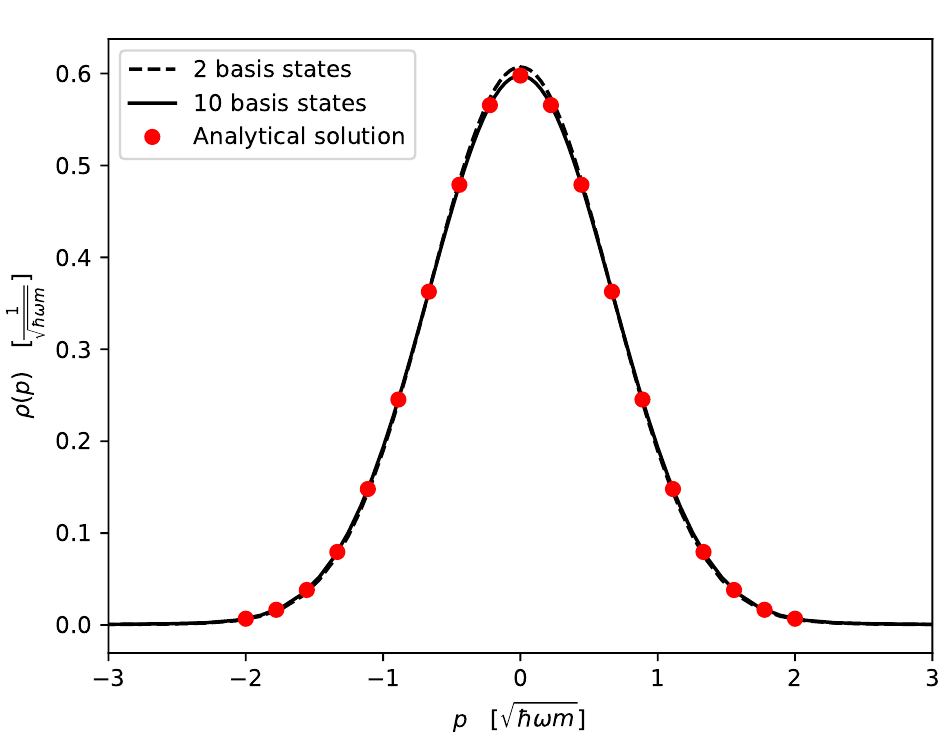
Figure 6: Momentum distribution of one of the particles in the ground state at (cid:113) m = 1 for the 1 + 1 system in the harmonic trap, compared with the analytical g ħ h 3 ω